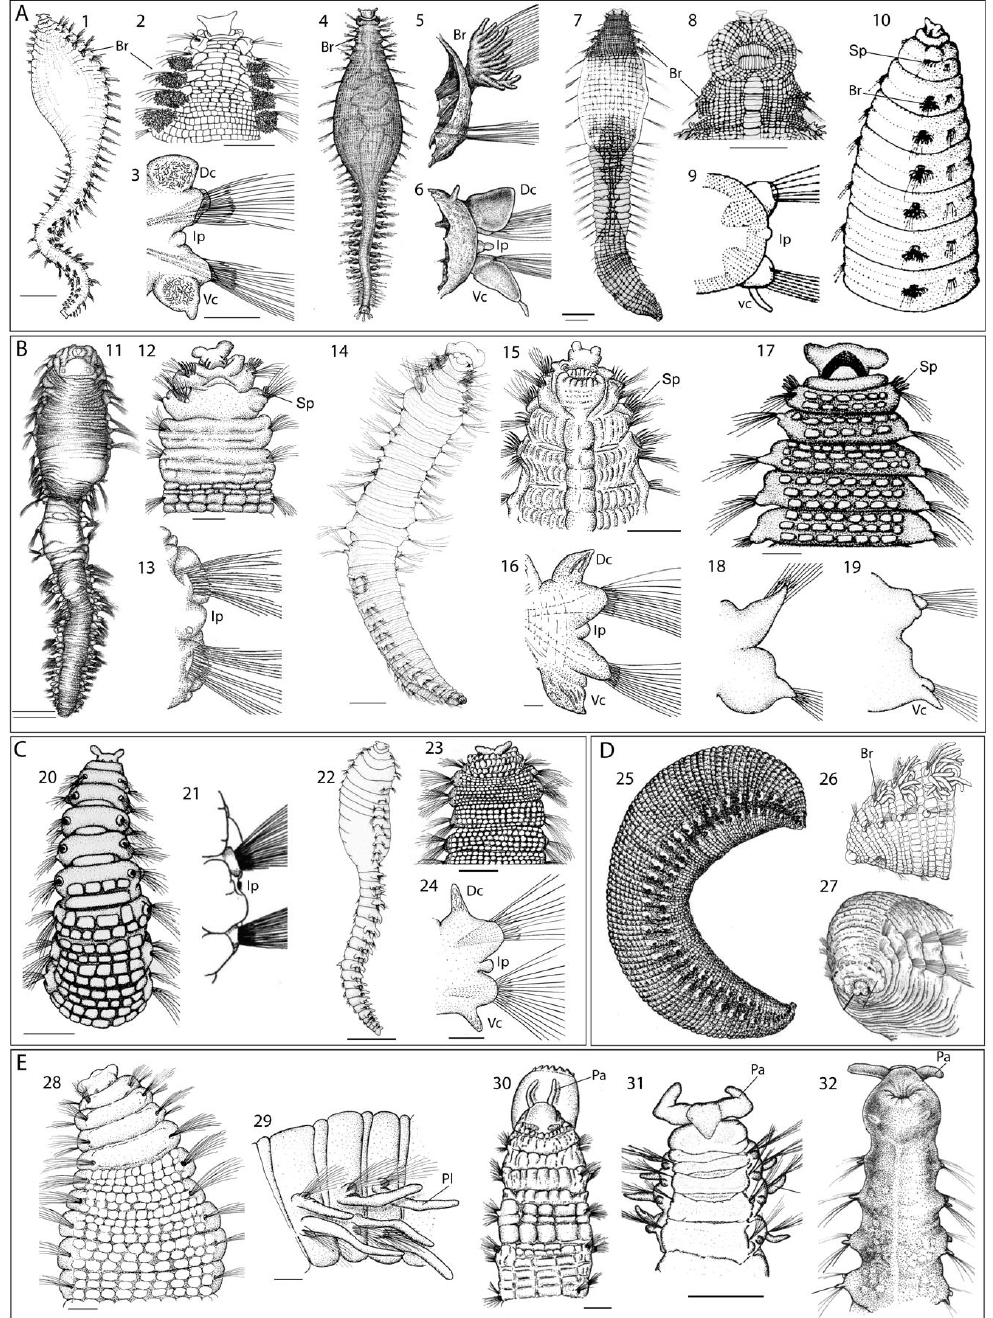
Figure 9. Stylized drawings showing the main taxonomic characters of different genera in Scalibregmatidae, artificially grouped according to the most conspicuous external traits. ( A ) Arenicoliform scalibregmatid genera with branchiae; genus Scalibregma , (1) S. hanseni , dorsal view, (2) S. inflatum , anterior end in dorsal view, (3) S. hanseni , left parapodium of chaetiger 21 in posterior view; genus Sclerobregma , (4) S. branchiatum , dorsal view, (5) chaetiger 3 in posterior view and (6) abdominal parapodium in anterior view; genus Cryptosclerocheilus , (7) C. baffinensis , dorsal view, (8) anterior end in ventral view; genus Parasclerocheilus , (9) P. capensis , chaetiger 40 and (10) anterior end in lateral view. ( B ) Arenicoliform scalibregmatids genera without branchiae and with spines; genus Asclerocheilus , (11) A. tasmanius , dorsal view, (12) A. kudenovi , anterior end dorsal view, (13) A. beringianus , chaetiger 15 in anterior view; genus Oligobregma (14) O. quadrispinosa , anterior view, (15) O. mucronata , anterior end in ventral view, (16) and posterior parapodium in anterior view; genus Sclerocheilus , (17) S. unoculus , anterior end in dorsal view, (18) chaetiger 16 in posterior view, and (19) chaetiger 29 in posterior view. ( C ) Arenicoliform scalibregmatid genera without branchiae and spines; genus Hyboscolex , (20) H. quadricincta , anterior end in dorsal view,